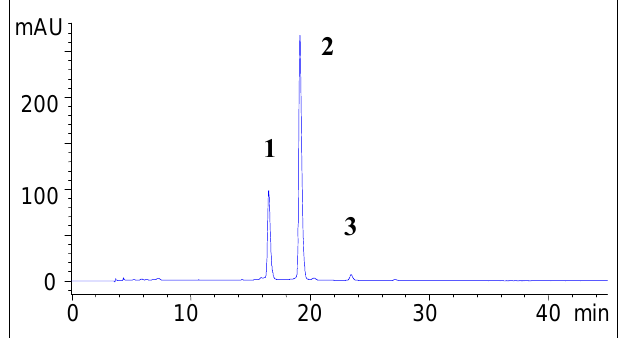
Figure 1. HPCL-DAD ( λ 530nm) of dried Delonix regia flower extracts, macerated with acidified deionized